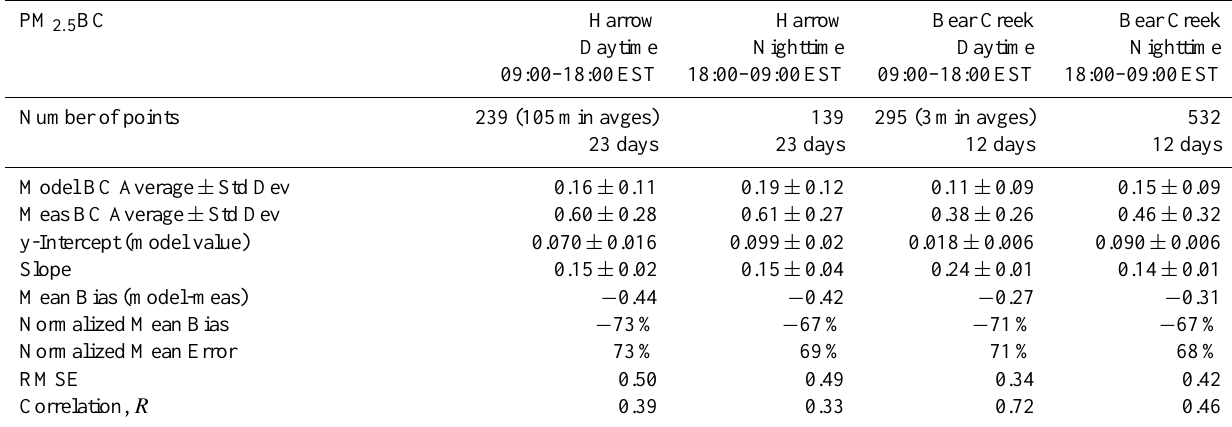
Table 9. AURAMS PM 2 . 5 BC model performance statistics for the 2.5-km grid for the rural Harrow and Bear Creek sites (concentrations in µgm − 3 ) .